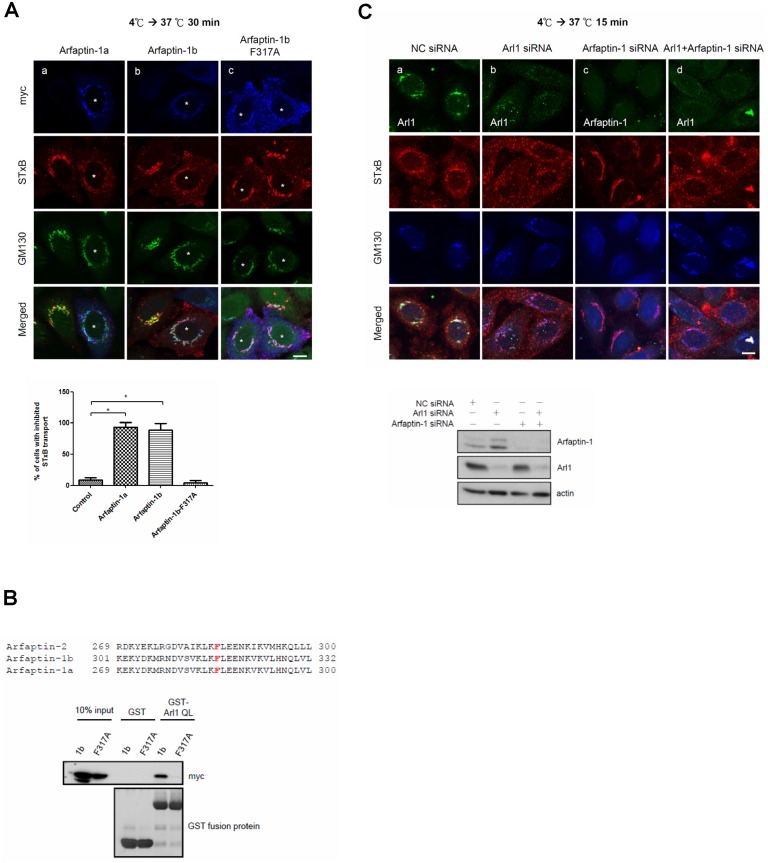
Arfaptin-1b overexpression inhibits STxB transport in an Arl1-dependent manner.(A) HeLa cells were transfected with arfaptin-1a-myc, arfaptin-1b-myc or arfaptin-1b-F317A-myc for 48 h. A STxB transport assay was conducted with incubation at 37°C for 30 min and the cells stained with anti-myc and anti-GM130 antibodies to detect exogenous arfaptin-1 and endogenous GM130, respectively. Scale bars, 10 μm. Asterisks indicate arfaptin-1a-myc- (a), arfaptin-1b-myc- (b) and arfaptin-1b-F317A-myc-expressing cells (c). The percentage of cells exhibiting inhibited STxB transport obtained from (A) was calculated (n>50 for each experiment), and the data are presented as the means±SDs; p<0.05 indicates significance, as determined by one-way ANOVA. (B) Arfaptin-1b-F317A-myc is unable to bind to the active form of Arl1. HeLa cells were transfected with arfaptin-1b-myc and arfaptin-1b-F317A-myc for 48 h. Recombinant GST and GST-Arl1QL were expressed in BL21 cells and immobilized on glutathione-sepharose resin. The immobilized GST fusion proteins were exchanged for GTPγS, and the proteins were incubated with lysates of transfected HeLa cells. The bound proteins were resolved on a 12.5% SDS-PAGE gel and analyzed by western blotting using an anti-myc antibody. The membrane was stained with Coomassie Brilliant Blue to demonstrate equal loading (lower panel). (C) Double knockdown of Arl1 and arfaptin-1 inhibits STxB transport. HeLa cells were transfected with control siRNA or siRNA specific to Arl1 or arfaptin-1 for 48 h. A STxB transport assay was performed with incubation at 37°C for 15 min, followed by immunofluorescence staining with anti-Arl1, anti-arfaptin-1 and anti-GM130 antibodies as indicated. Scale bars, 10 μm.